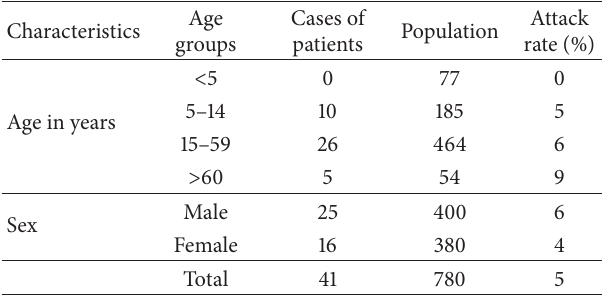
Table 1: Age and sex specific attack rate of diarrhea cases